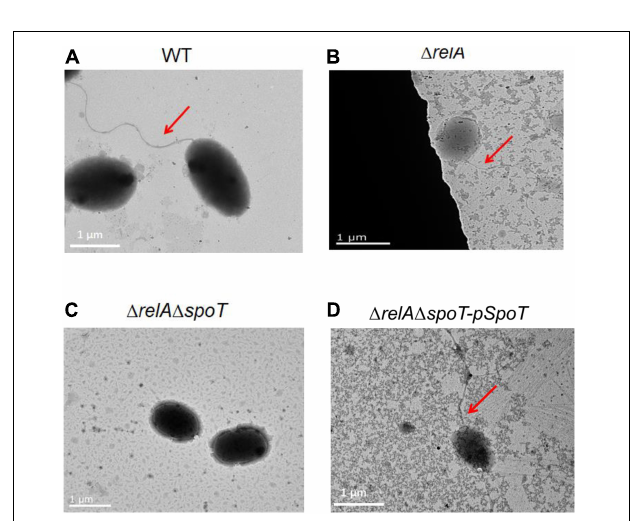
FIGURE 4 | The effects of relA and spoT on the synthesis of flagellum. Transmission electron microscopic visualization of flagellum in WT (A) , (cid:49) relA (B) , (cid:49) relA (cid:49) spoT (C) and (cid:49) relA (cid:49) spoT -pSpoT (D) . Red arrow indicates the flagellum and scale bar = 1 µ m for all panels.